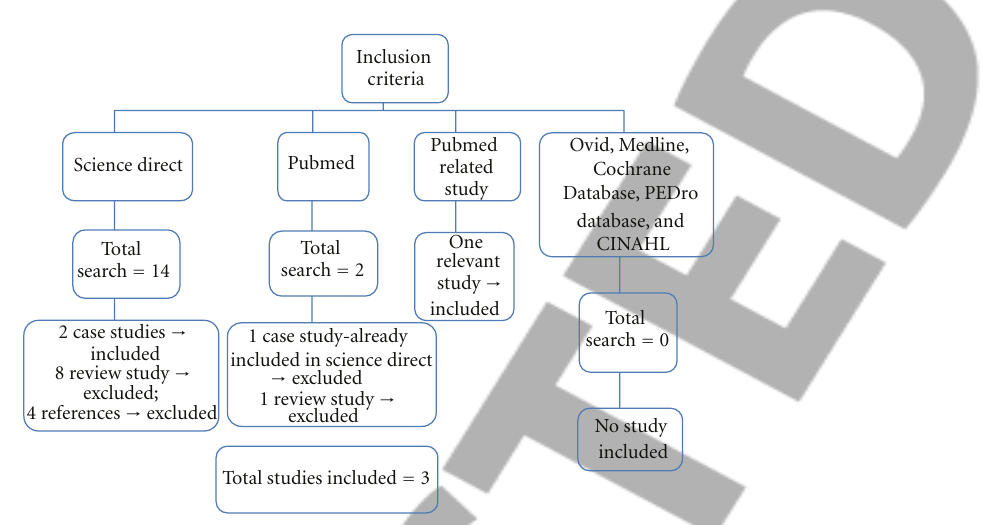
Figure 1: Flowchart indicating the method of selection of the